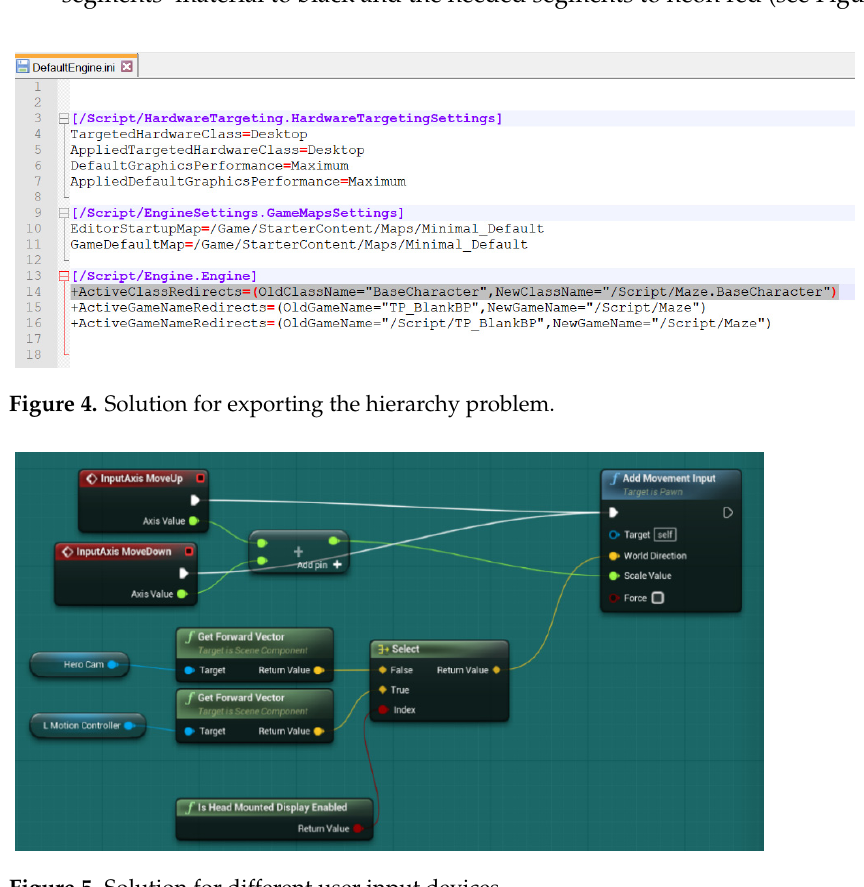
Figure 5. Solution for different user input devices.